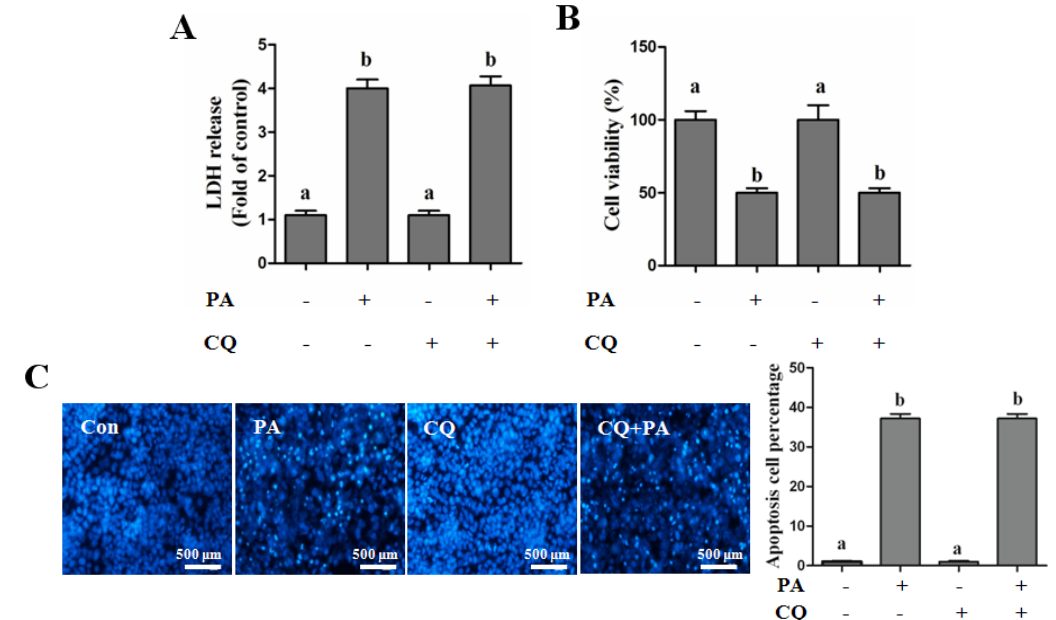
Figure 5. Short ‐ term inhibition of autophagy does not aggravate palmitate ‐ induced hepatic lipotoxicity. HepG2 cells were exposed to autophagy inhibitor (CQ, 20 μ M) for 1 h, after then the cultural medium was totally replaced by the fresh medium containing only palmitic acid (PA, 400 μ M) and treated for 12 h. The lipotoxicity was detected. ( A ) LDH in the cultured medium was detected as described in the Methods section; ( B ) Cell viability was detected by MTT test; ( C ) Nuclear morphology was detected by Hoechst staining using fluorescence microscopy (magnification × 100). Each test was performed at least 3 times. Bars with different characters differ significantly ( p < 0.05).